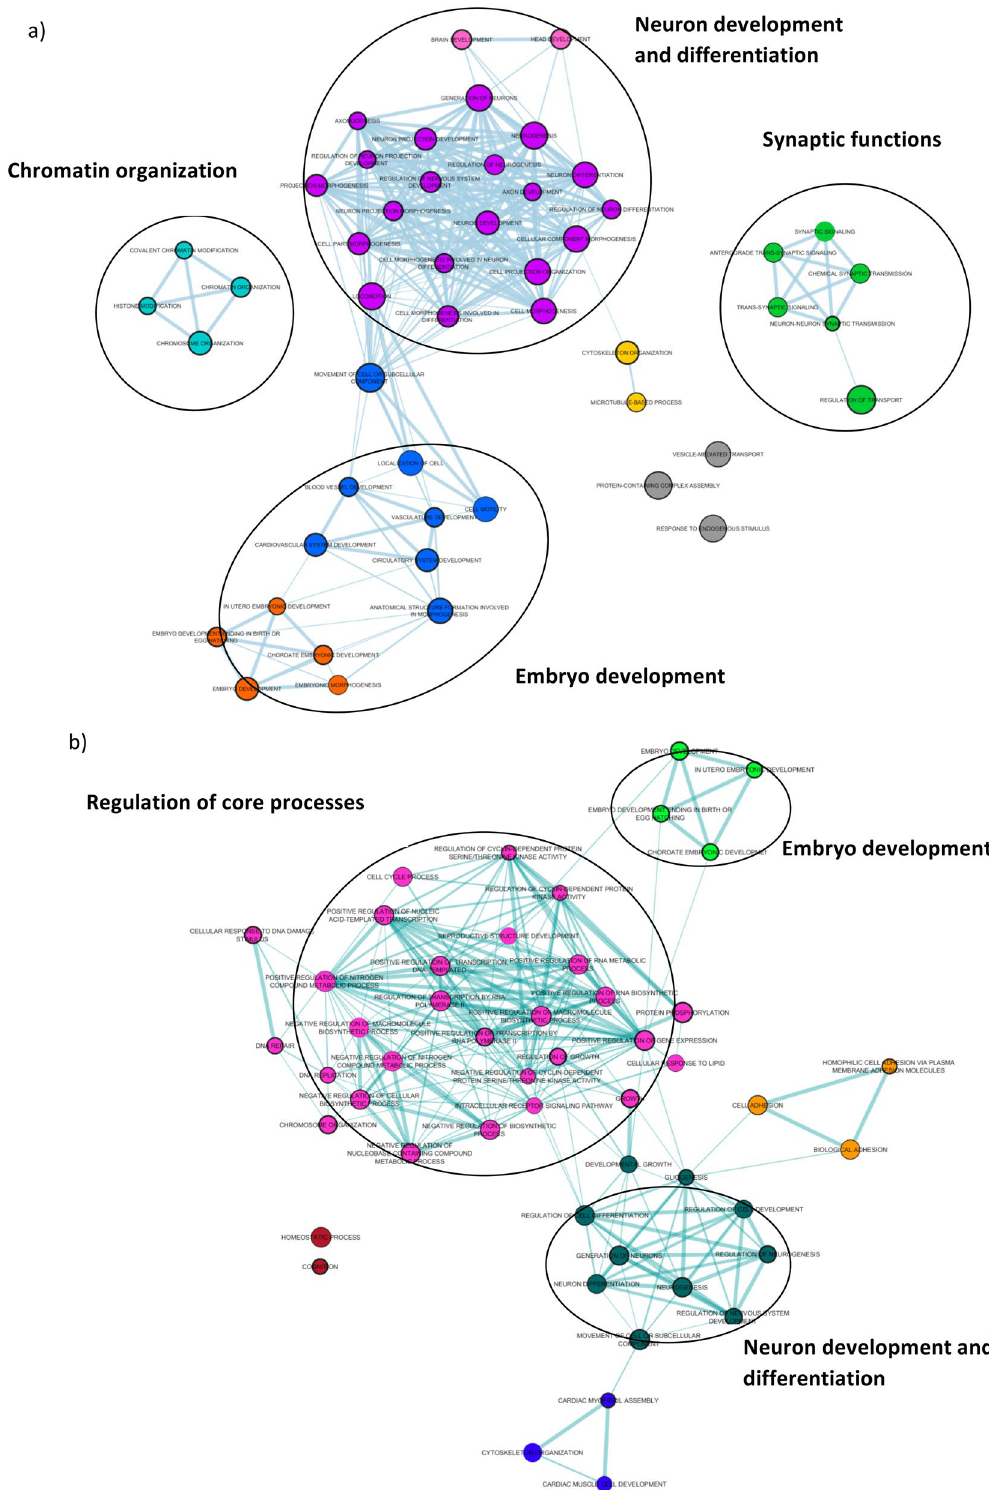
Figure 4. Visualization of the top 50 GO terms grouped by clusters of biological functions (DNMs obtained from the combined cohort) ( a ) GO terms clusters for genes harboring germinal mutations. ( b ) GO terms clusters for genes harboring